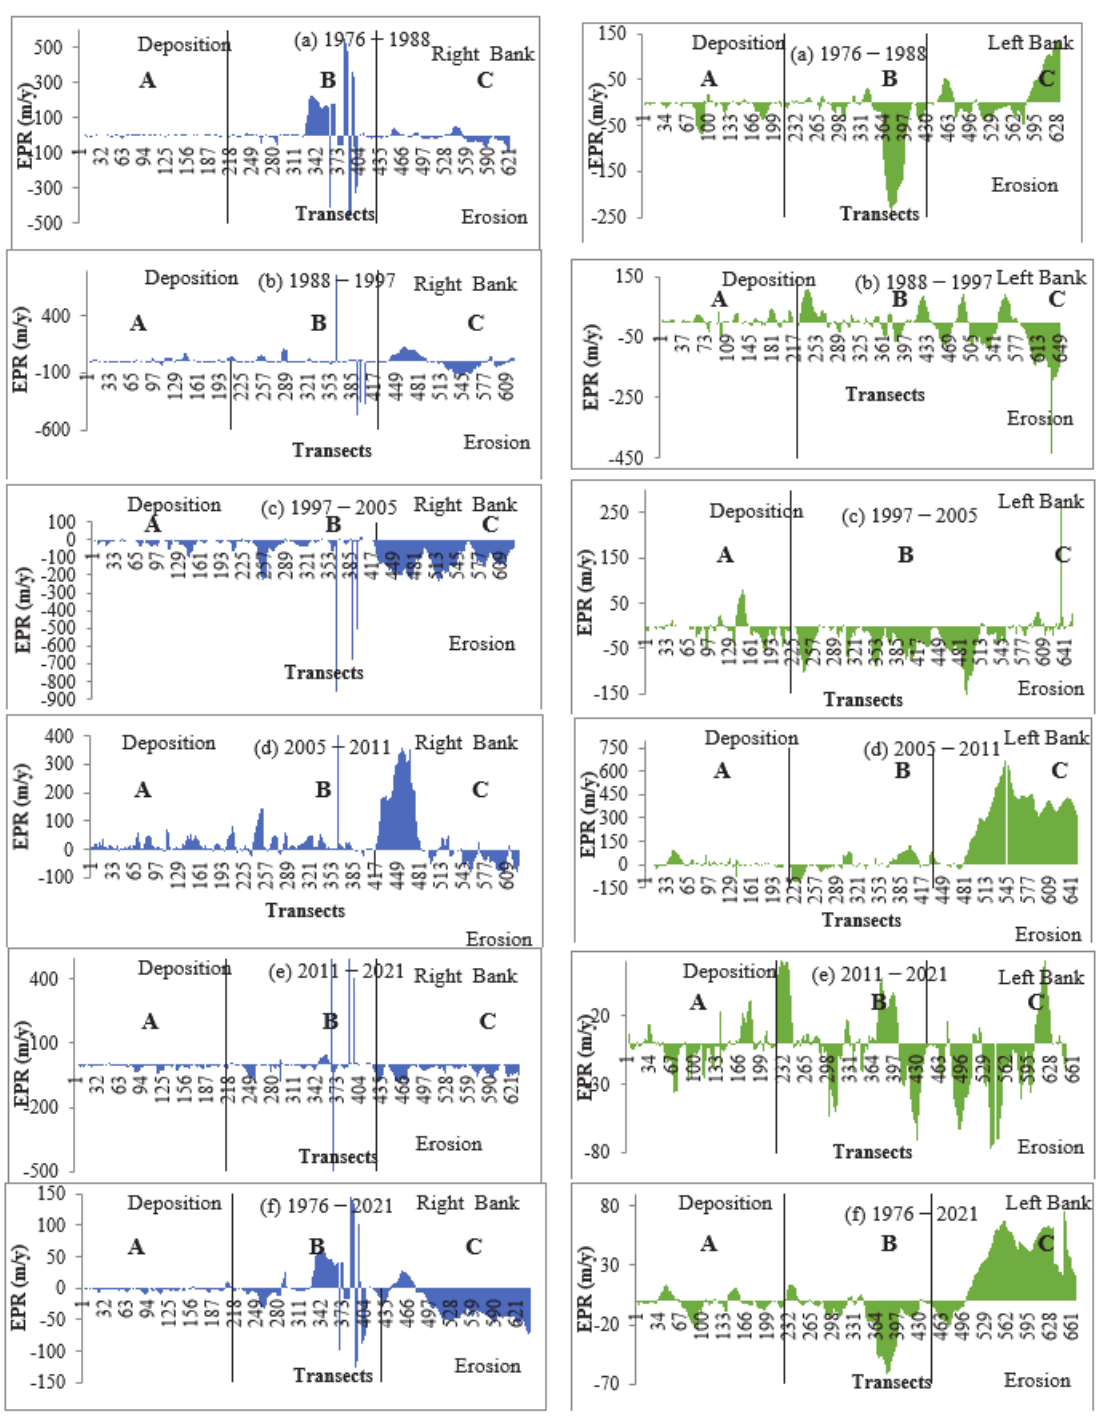
Figure 5. EPR-based channel migration rate (erosion and deposition) during the periods